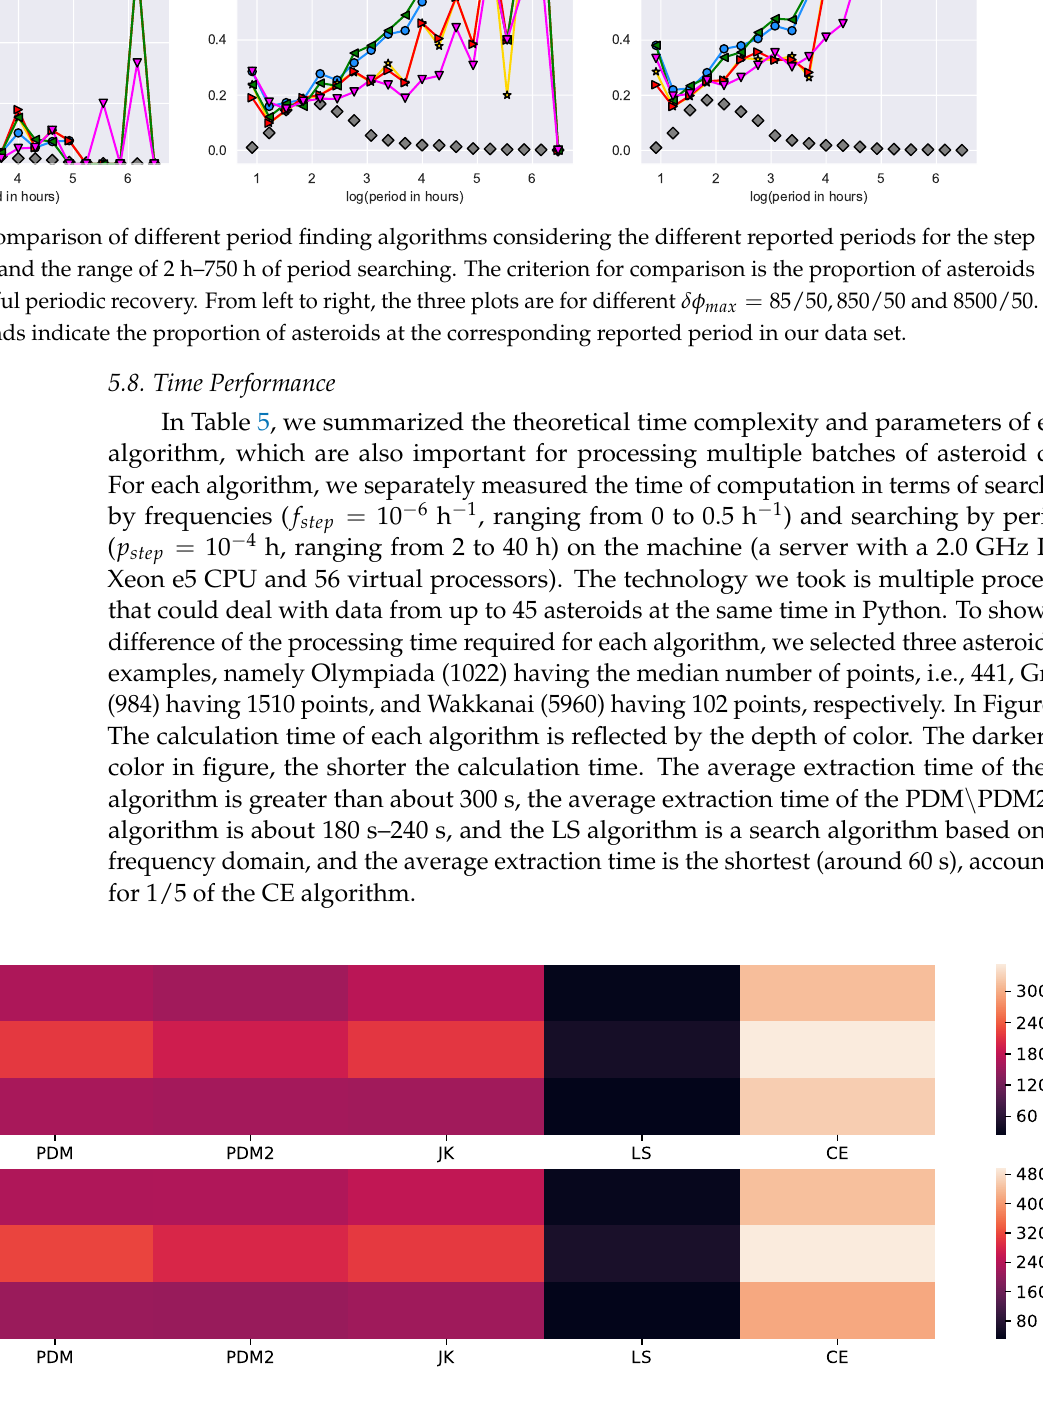
Figure 14. Calculation time in seconds for Olympiada (1022), Gretia (984) and Wakkanai (5960). Top panel: searching by periods with p step = 10 − 4 h and searching range from 2 to 40 h. Bottom panel: searching by frequencies with f step = 10 − 6 h − 1 and searching range from 0 to 0.5 h − 1